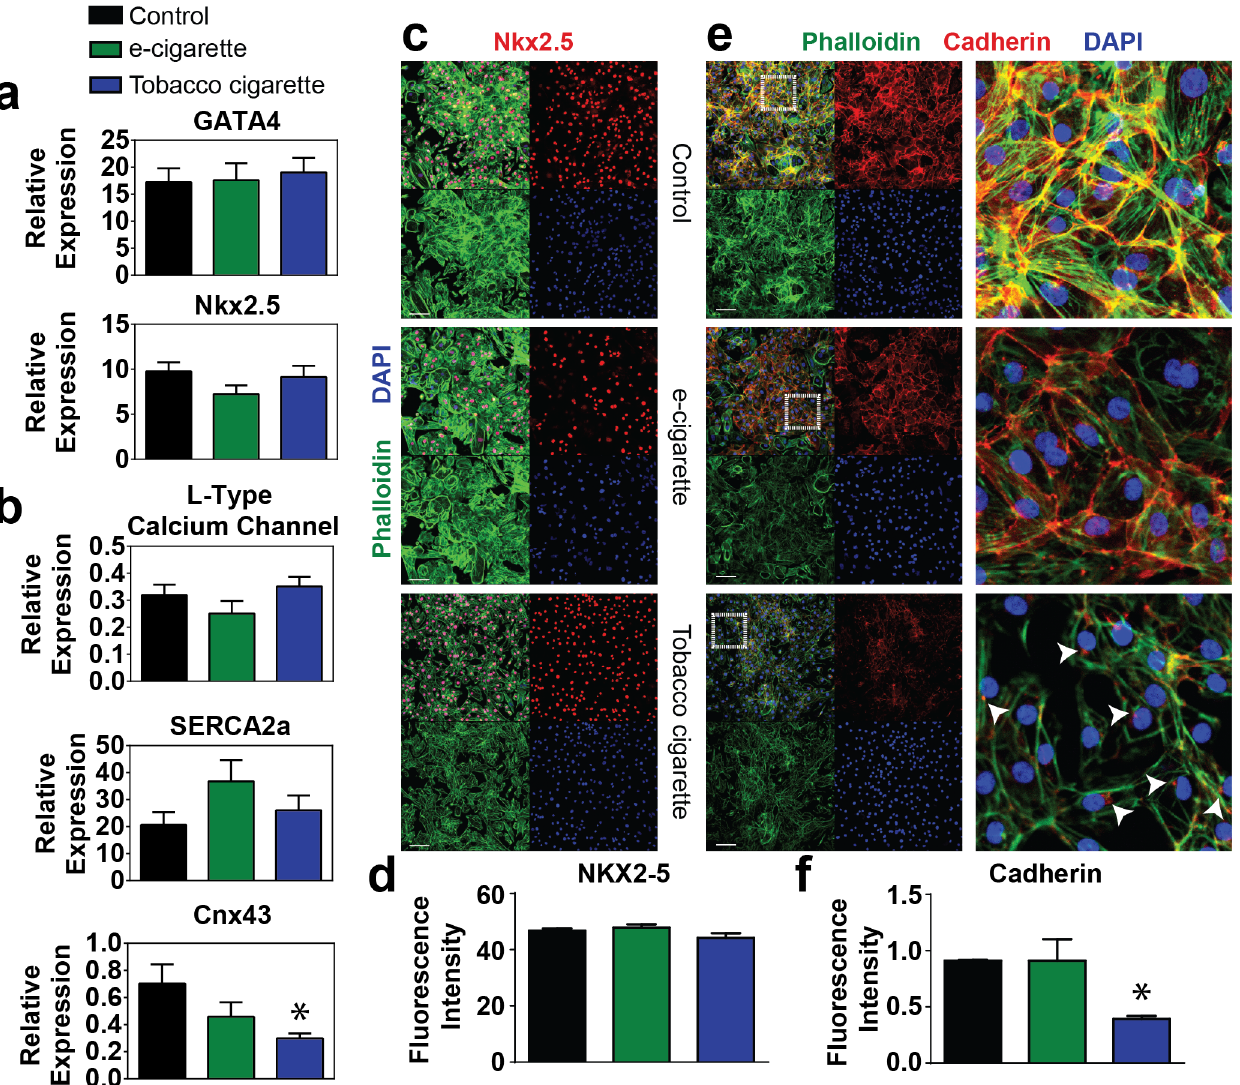
Fig 5. Analysis of hESC derived fetal cardiomyocyte transcription factor, calcium handling, and junction protein expression. (a) Expression level of cardiac transcription factors GATA4 and NKX2.5 (a) and calcium handling proteins including the L-type calcium channel and SERCA2a, and the junctional protein CNX43 (b) by quantitative RT-PCR in cells treated with 6.8 μ M e-cigarette or tobacco cigarette extracts vs. control. (c-d) Representative immunocytochemistry (c) and quantification (e) for NKX2.5 in fetal cardiomyocytes with various cigarette treatments compared to control. (e-f) Representative immunohistochemistry (e) and quantification (f) for the junction protein cadherin in fetal hESC cardiomyocytes with various cigarette treatments compared to control. Inset shown to the right. Arrows indicate perinuclear expression of cadherin. n (cid:3) 6 per group. Scale bar = 100 μ m. * P <